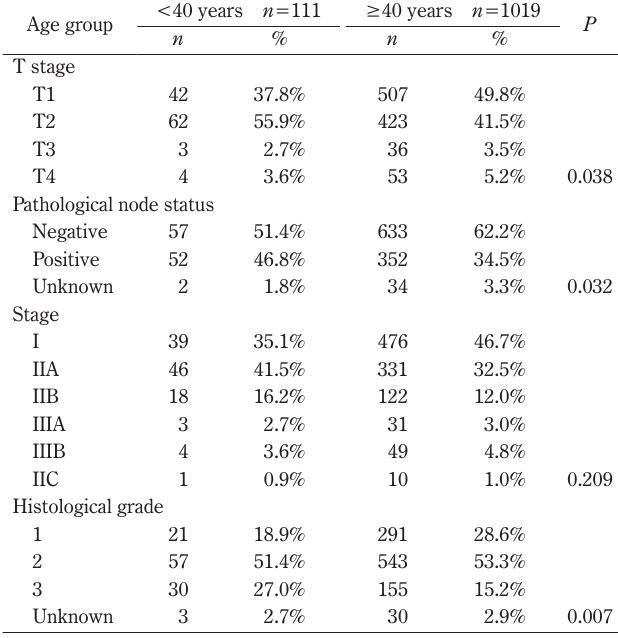
Figure 1 Distribution of age at diagnosis among 1,130 patients. Table 1 Breast tumor pathologic characteristics by